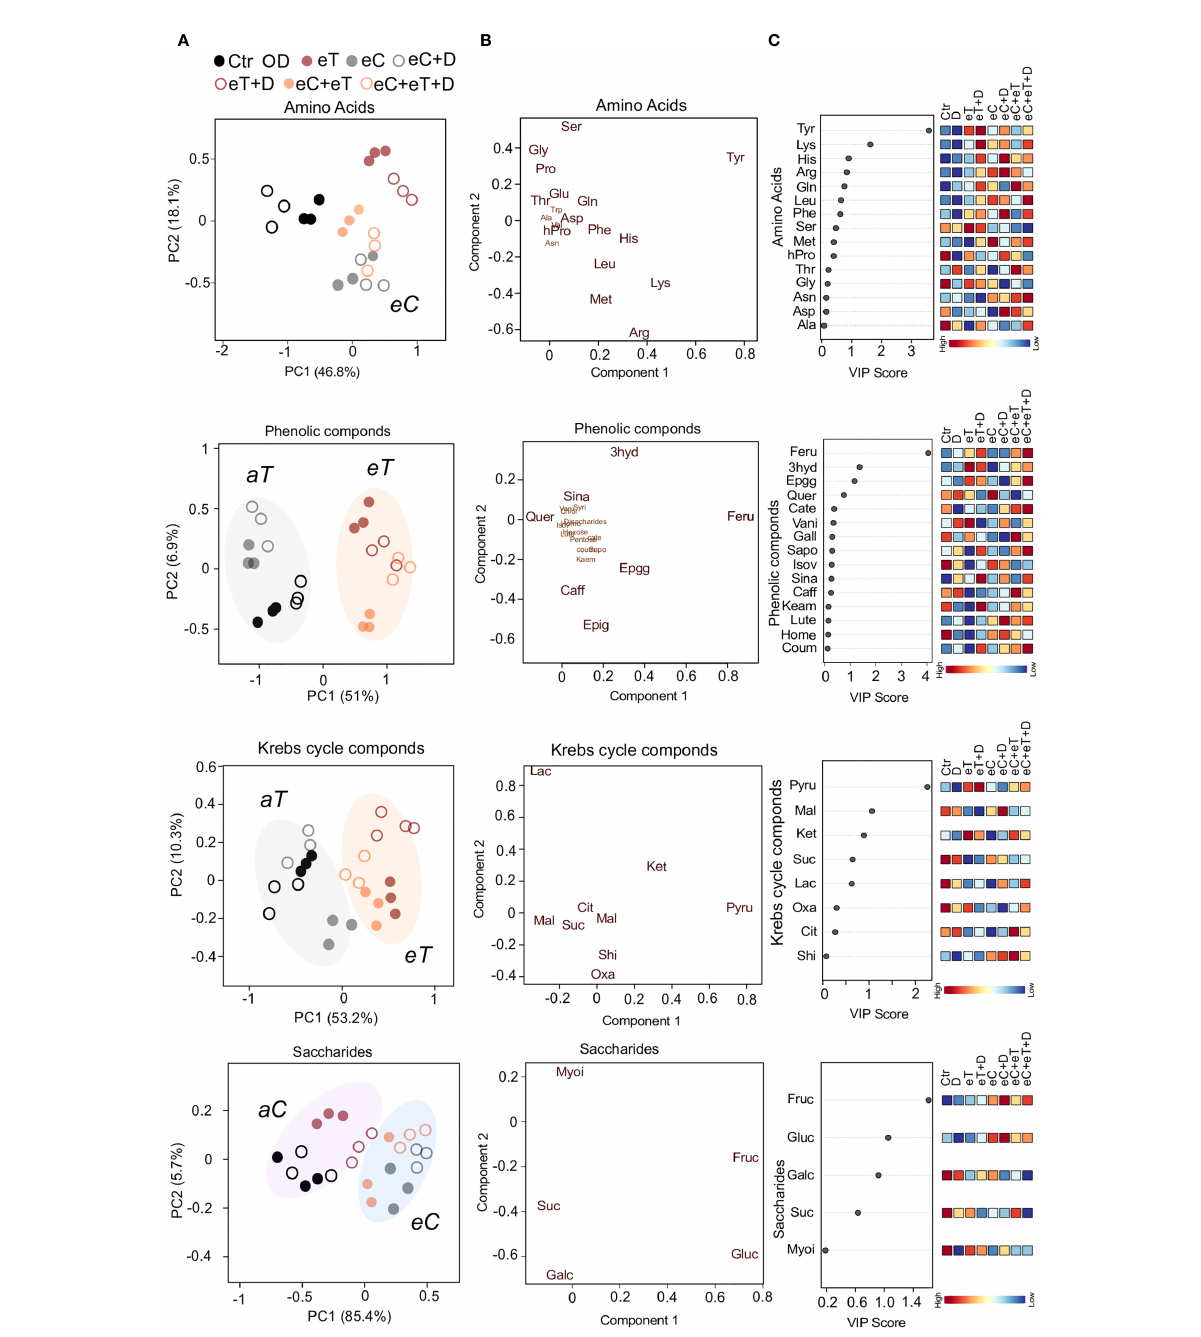
FIGURE 4 A supervised Partial Least Squares Discriminant Analysis (PLS-DA) of key metabolite categories accumulated in the leaves of wheat cv. Cadenza after exposure to climate regimes. (A) Scores plot showing the distribution of metabolites (amino acids; phenolics, Krebs cycle intermediates; saccharides) based on the regimes. Component 1 separated the metabolites based on the ambient temperature (aT, gray circle), elevated temperature ( eT , orange circle). Ambient CO 2 ( aC , purple circle), and elevated CO 2 concentrations (eC, blue circle). (B) Loading plot showing the metabolites (amino acids; phenolics, Krebs cycle intermediates; saccharides) discriminated based on PLS-DA. The metabolites in the bigger font signi fi cantly ( P ≤ 0.05) varied among the treatments. (C) The metabolites ranked by variable importance in projection (VIP). Scale bar represents high and low VIP scores corresponding to the metabolites. Ctr, control treatment; eC, elevated CO 2 ; eT, elevated temperature; D, drought; eC+eT, elevated CO 2 and elevated temperature; eC+ D, elevated CO 2 and drought; eT+D, elevated temperature and drought; eC+eT+D, elevated CO 2 , elevated temperature and drought. Abbreviations of the metabolites are provided in Supplementary Table